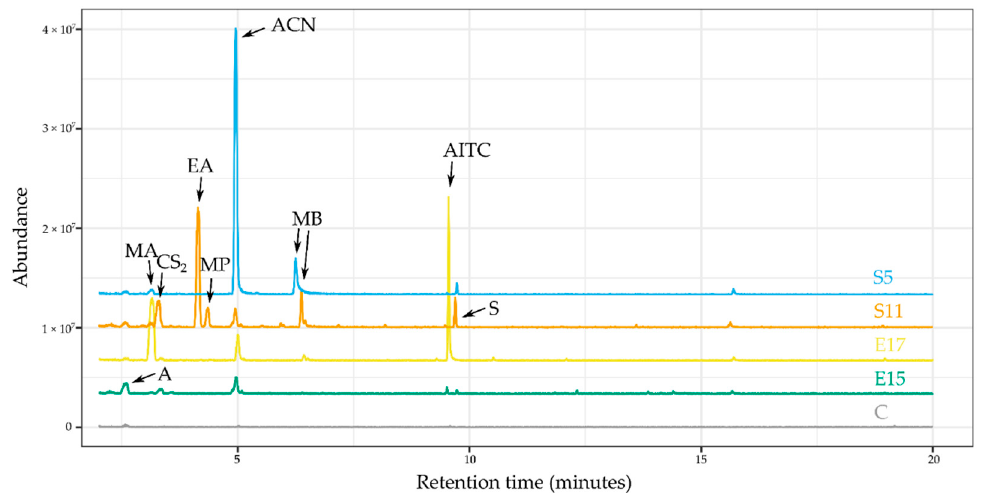
Figure 1. Representative total ion chromatograms (TICs) from the headspace of horseradish extract incubated with various endophytic fungi and soil fungi. Chromatogram traces (from bottom to top):